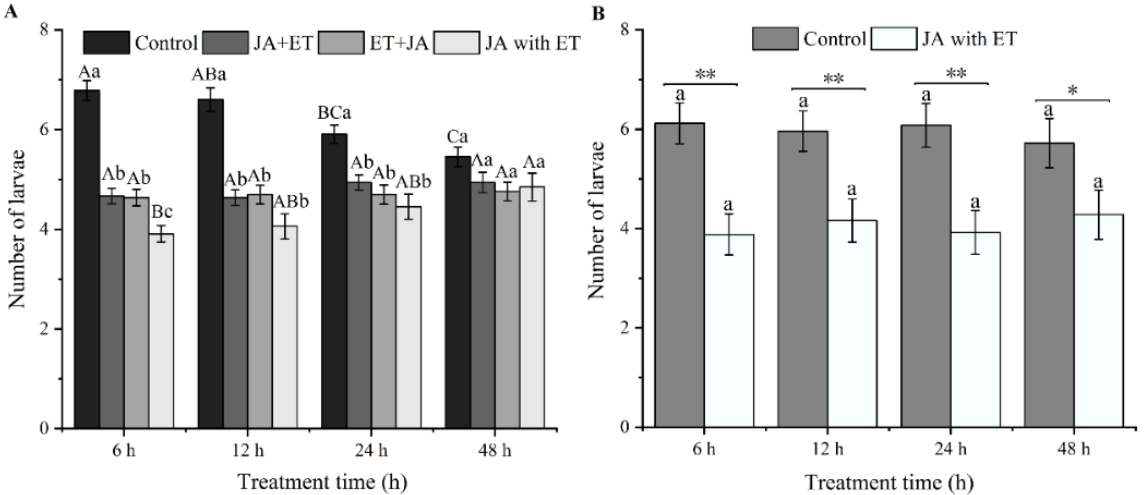
Figure 3. Effects of combined jasmonic acid and ethylene treatments on Frankliniella occidentalis spawning in faba bean plants. ( A ): Four different JA/ET treatments. Data are presented as mean ± standard error (n = 33). Different capital letters above the bars indicate significantly different mean numbers of thrips among the different time periods of the same treatment, while different small letters indicate significant differences among the different treatments at the specified time period ( p < 0.05; one-way analysis of variance, Tukey’s test); ( B ) Two treatments (JA with ET and a control). Data are presented as mean ± standard error (n = 25). Different small letters above the bars show significant differences at the 0.05 level among different times at the same treatment (Tukey multiple range test); “*” and “**” indicate significant differences at the 0.05 and 0.01 levels among different treatments for the same time period.